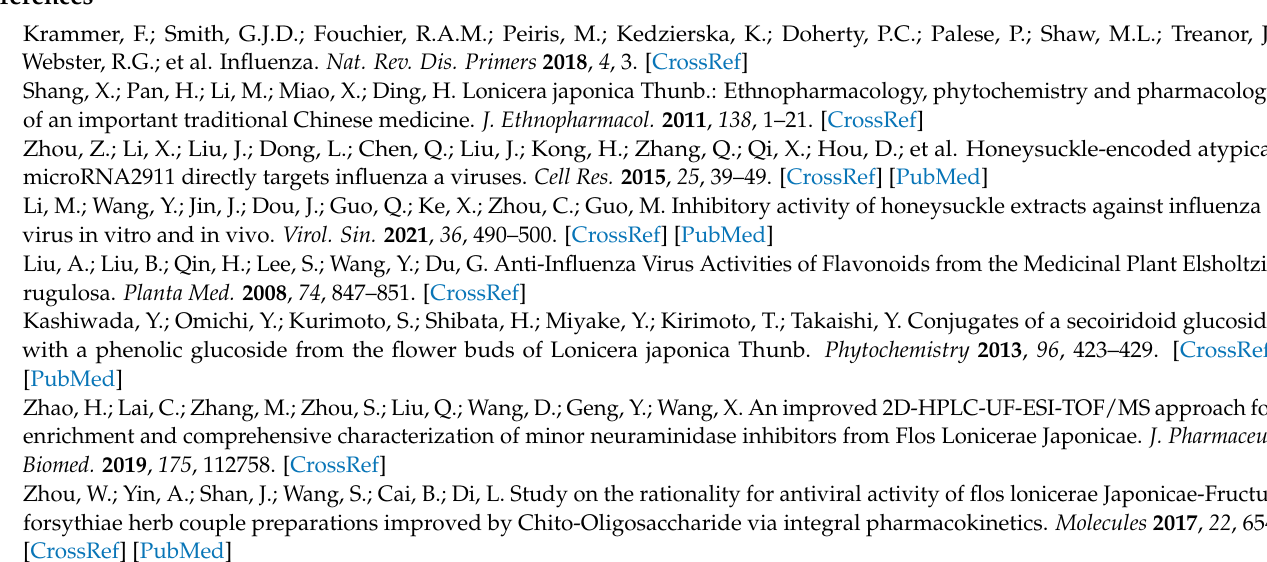
Table S4: The contents of 6 bioactive compounds in 71 batches of Lonicerae japonicae flos samples, Table S5: Linearity, limit of detection (LOD) and limit of quantification (LOQ) data of the 6 bioac- tive compounds, Table S6: Precision, stability and recovery results of the 6 bioactive compounds, Figure S1: The IC 50 of NA inhibitory activity of cultivated Lonicerae japonicae flos (a) and wild Lonicerae japonicae flos (b), Figure S2: Outlier detection by PCA with 95% confidence. (a) PCA scores plots of 71 batches of Lonicerae japonicae flos. (b) PCA scores plots of 61 batches of cultivated Lonicerae japonicae flos (cLJF). (c) PCA scores plots of 10 batches of wild Lonicerae japonicae flos (wLJF), Figure S3: The NA inhibitory activity of Lonicerae japonicae flos samples. (a) LDA scores plots of cultivated Lonicerae japonicae flos samples from Shandong, Henan and Hebei processed by hot-air drying based on 6 bioactive peaks. (b) The NA inhibition rates of cultivated Lonicerae japonicae flos samples from Shandong, Henan and Hebei processed by hot-air drying. (c) LDA scores plots of cultivated Lonicerae japonicae flos samples from Shandong, Henan and Hebei processed by sun drying based on 6 bioactive peaks. (d) The NA inhibition rates of cultivated Lonicerae japonicae flos samples from Shandong, Henan and Hebei processed by sun drying. (* p < 0.05, ** p < 0.01, “ns” means “not significant”, p > 0.05, compared with each other.), Figure S4: The IC 50 of NA inhibitory activity of bioactive compounds. Neochlorogenic acid (a), chlorogenic acid (b), cryptochlorogenic acid (c), sweroside (d), secoxyloganin (e) and 4,5-Di- O -caffeoylquinic acid